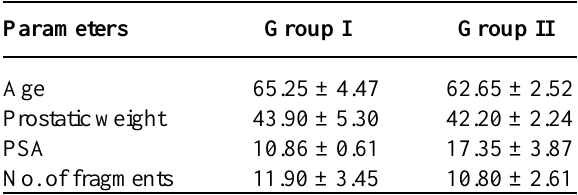
Table 1 – Mean and standard deviation for age, prostatic weight as measured by ultrasound, PSA value and number of fragments in groups I and II.